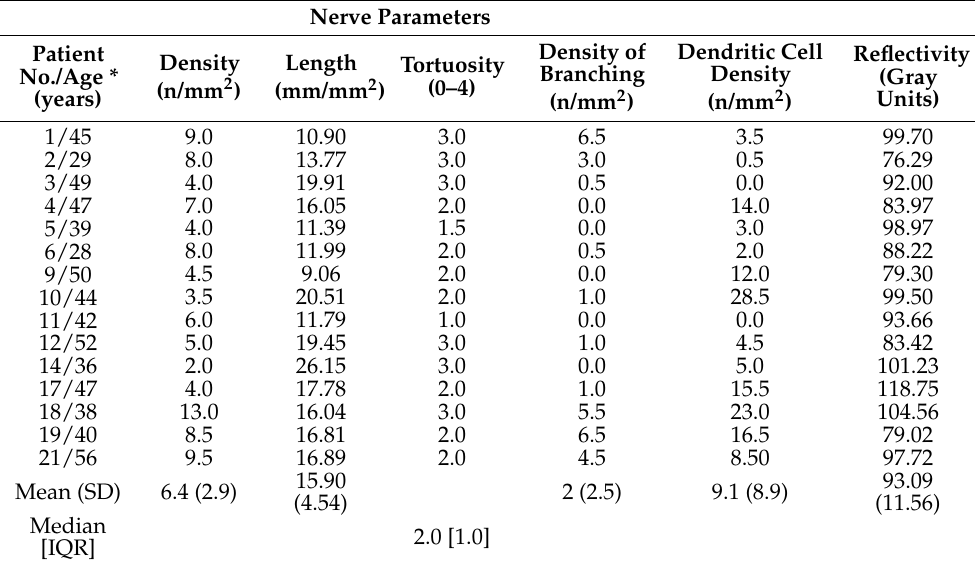
Table 3. Corneal morphological data obtained by in vivo confocal microscopy of mercury-poisoned patients. Nerve Parameters